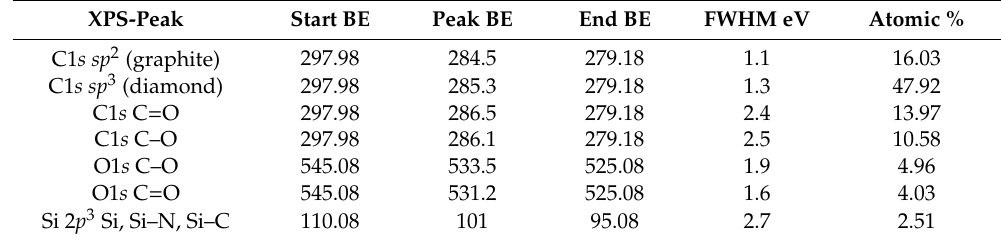
Table 4. Results of XPS-analysis software interpretation: composition and energy characteristics of DLC peaks (without sublayer).